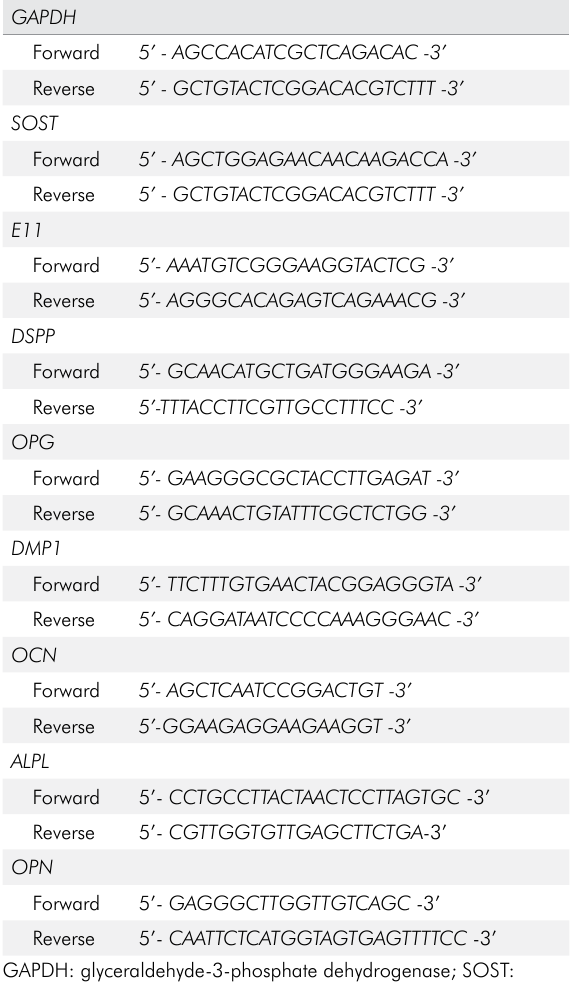
Table 2. Primers